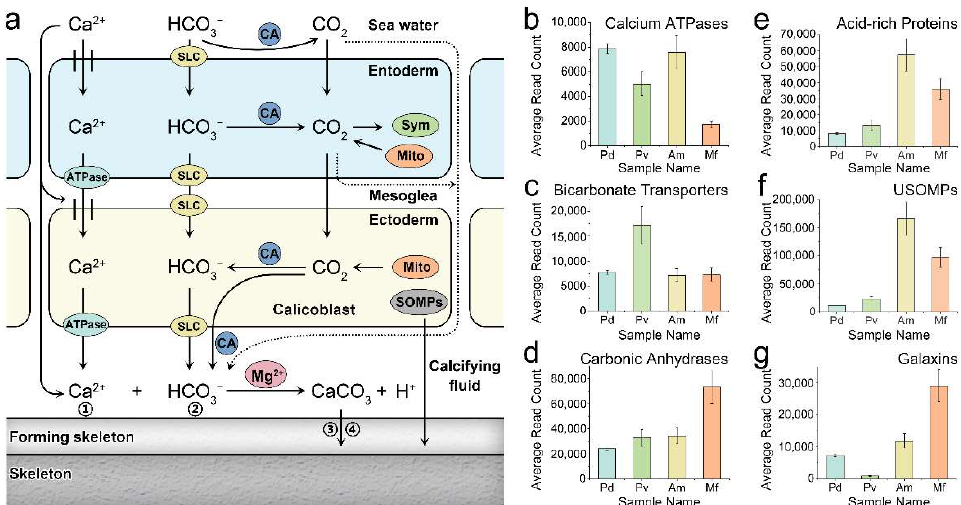
Figure 4. Mechanism of coral biomineralization and related gene expression levels. ( a ) The mecha- nism of reef-building coral biomineralization. (1) Ca 2+ transport by calcium ATPase or diffusion. (2) CO 2 can be converted into HCO 3− by CA and then exits the cells via bicarbonate transporters (i.e., SLC4 and SLC26). (3) Coral acid-rich proteins and Mg 2+ can promote crystal nucleation, determine growth axes, and control crystal growth. (4) The bioprecipitation of aragonite crystals in corals requires additional skeletal organic matrix proteins (USOMPs, galaxins, and alpha IV collagen). The average expression levels of genes belonging to calcium ATPases ( b ), bicarbonate transporters ( c ), carbonic anhydrases ( d ), acid-rich proteins ( e ), USOMPs ( f ), and galaxins ( g ). The horizontal axis shows the sample name, and the vertical axis represents the average read-count values of each set of genes. ATPase: calcium ATPase; SLC: solute carriers 4 (SLC4) and 26 (SLC26); CA: carbonic an- hydrase; Sym: Symbiodiniaceae; Mito: mitochondrion; and SOMPs: coral acid-rich proteins, alpha IV collagen, galaxins, and uncharacterized skeletal organic matrix proteins (USOMPs). The solid lines represent definite paths and the dashed lines represent possible paths. Table 4. Average read-count values of key biomineralization-related genes in four investigated cor- als.